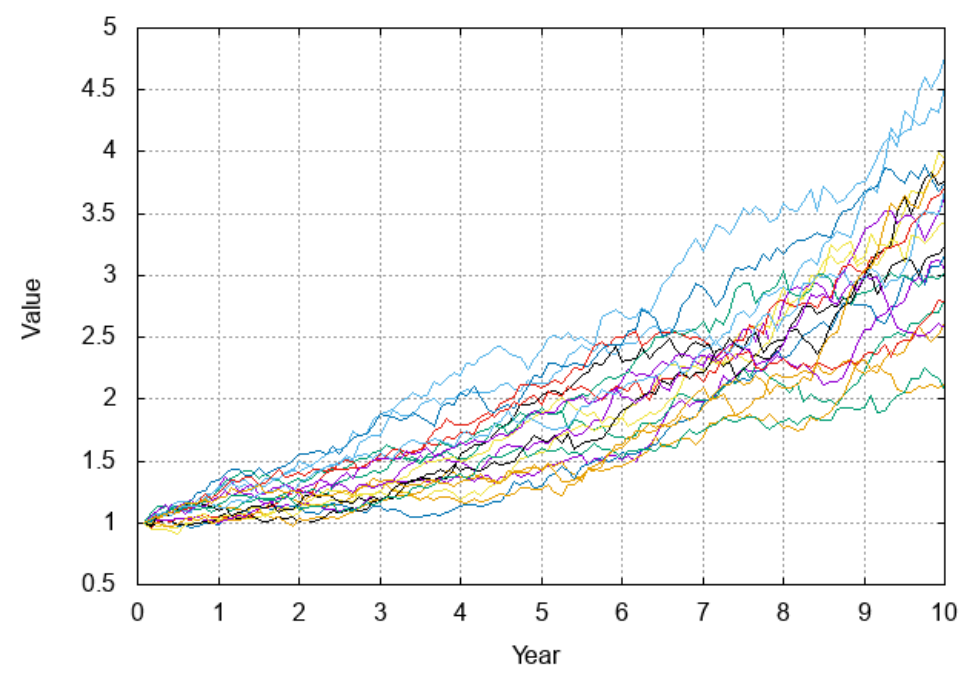
Figure 3. Reversals strategy performance, 20 simulations of 30 stocks, mean reversion